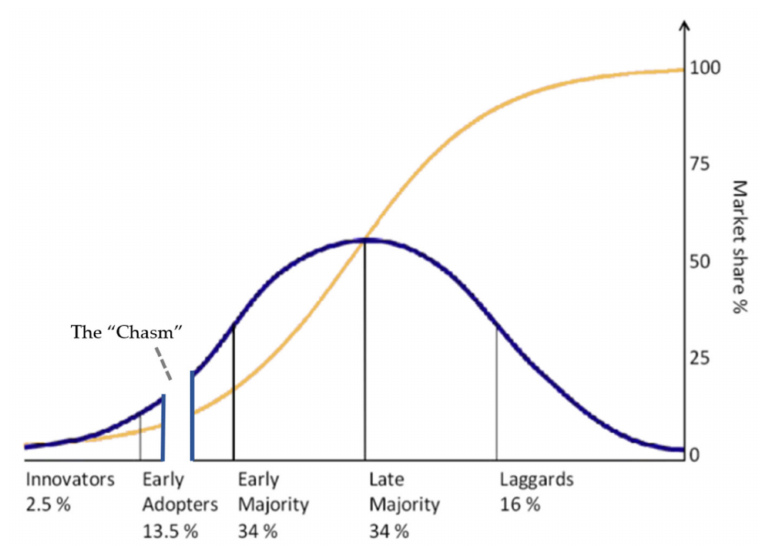
Figure 3. The course of adoption of innovations in time for individual categories of adopters